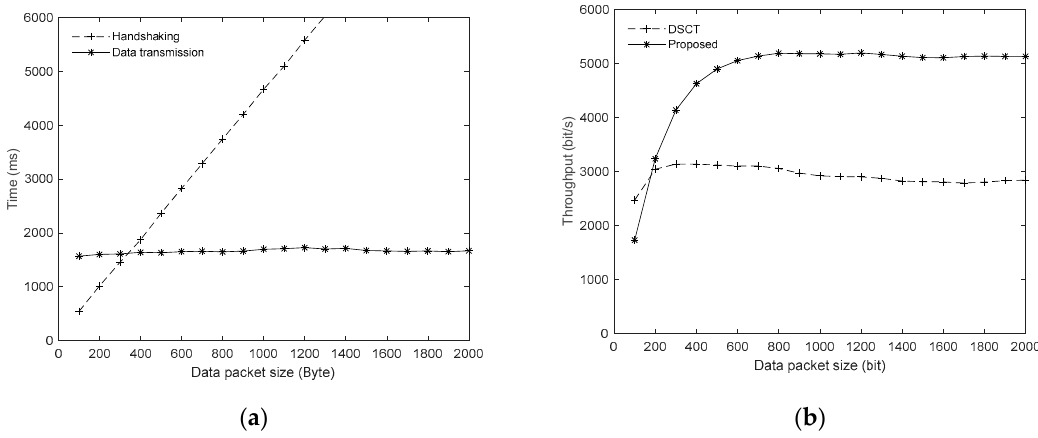
Figure 8. Influence of packet size. ( a ) durations for handshaking and data transmission under different packet sizes; ( b ) throughputs of DSCT and the proposed protocols under different packet sizes.